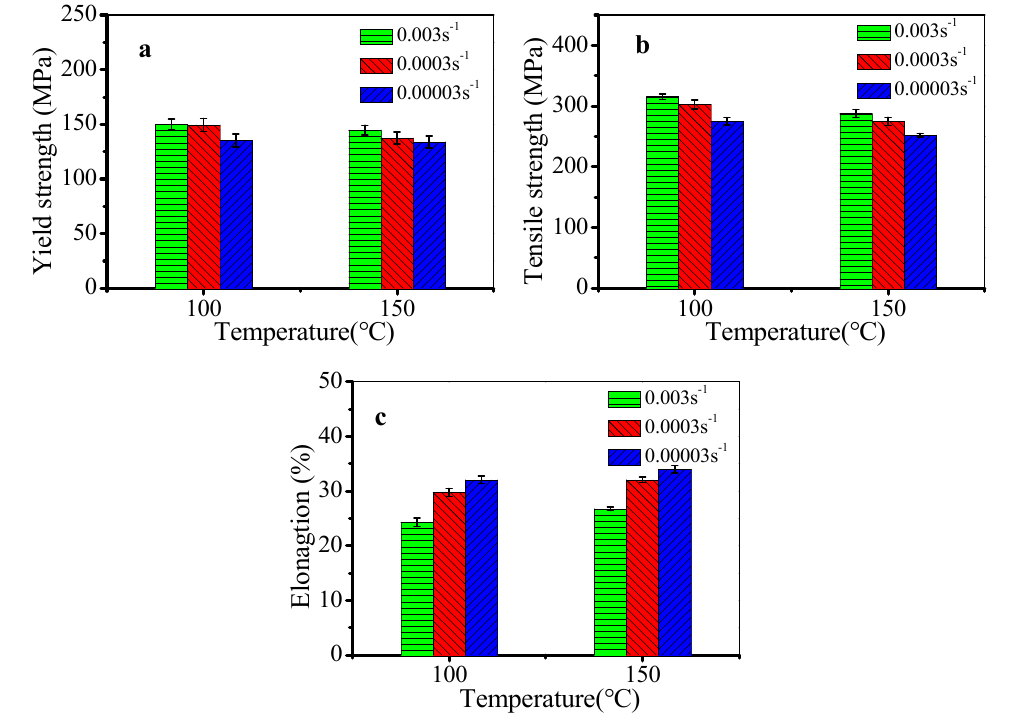
Figure 10. TEM images and SAED patterns of the stretched alloy at ( a ) T = 100 °C, ε = 0.0003 s − 1 ; ( b ) T = 150 °C, ε = 0.0003 s − 1 ; ( c ) T = 200 °C, ε = 0.0003 s − 1 ; ( d ) T = 250 °C, ε = 0.0003 s − 1 ; and ( e ) T = 200 °C, ε = 0.00003 s − 1 .